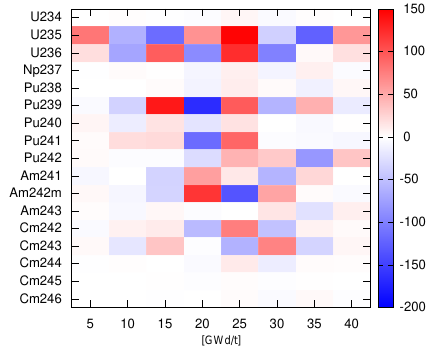
Figure 4. Weights of individual mockup parameters in the ficti- tious mockup parameters for k